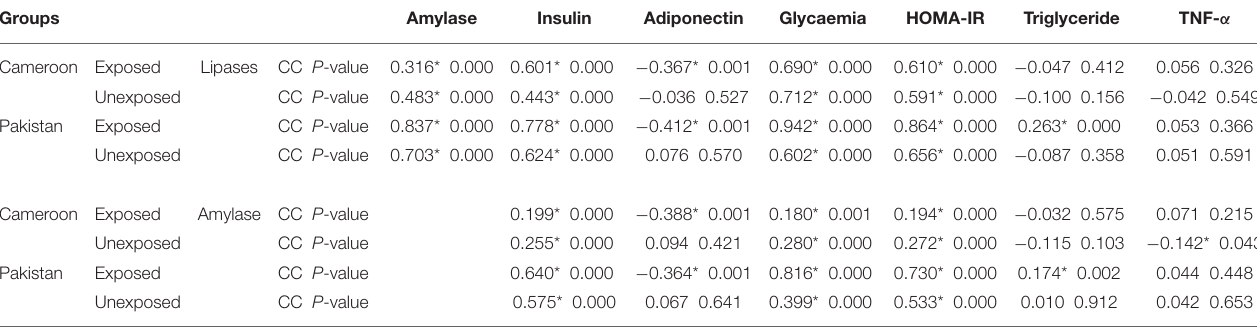
TABLE 4B | Correlation of Lipases and Amylase with Biochemical tests.